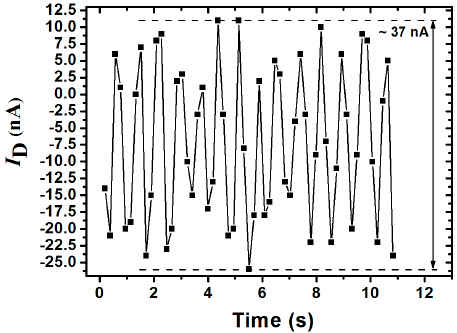
Figure 6. Current fluctuation in the proposed sensor.